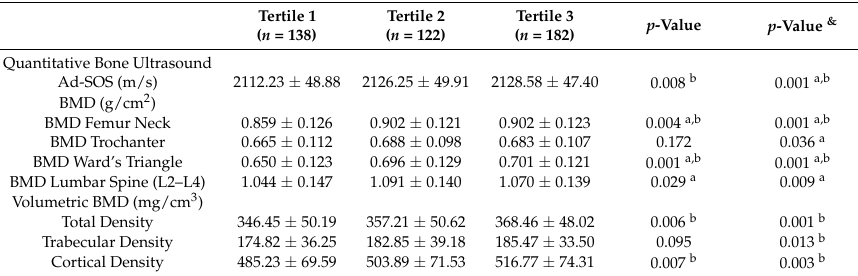
Table 2. Bone density by tertiles of Mediterranean diet score.